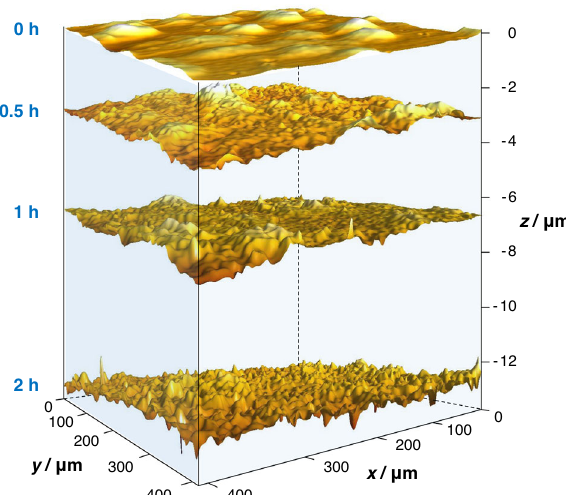
Fig. 3 3D visualization of the initial phase of degradation. The stacked VSI maps show an unspeci fi c roughening process, eliminat- ing a hilly topography present at the beginning.